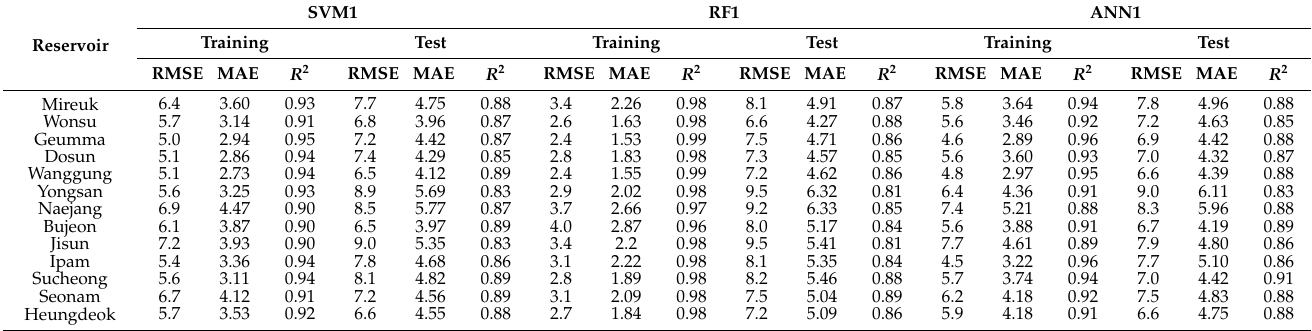
Table 5. Performance of applied models in the training and test phases for one-month